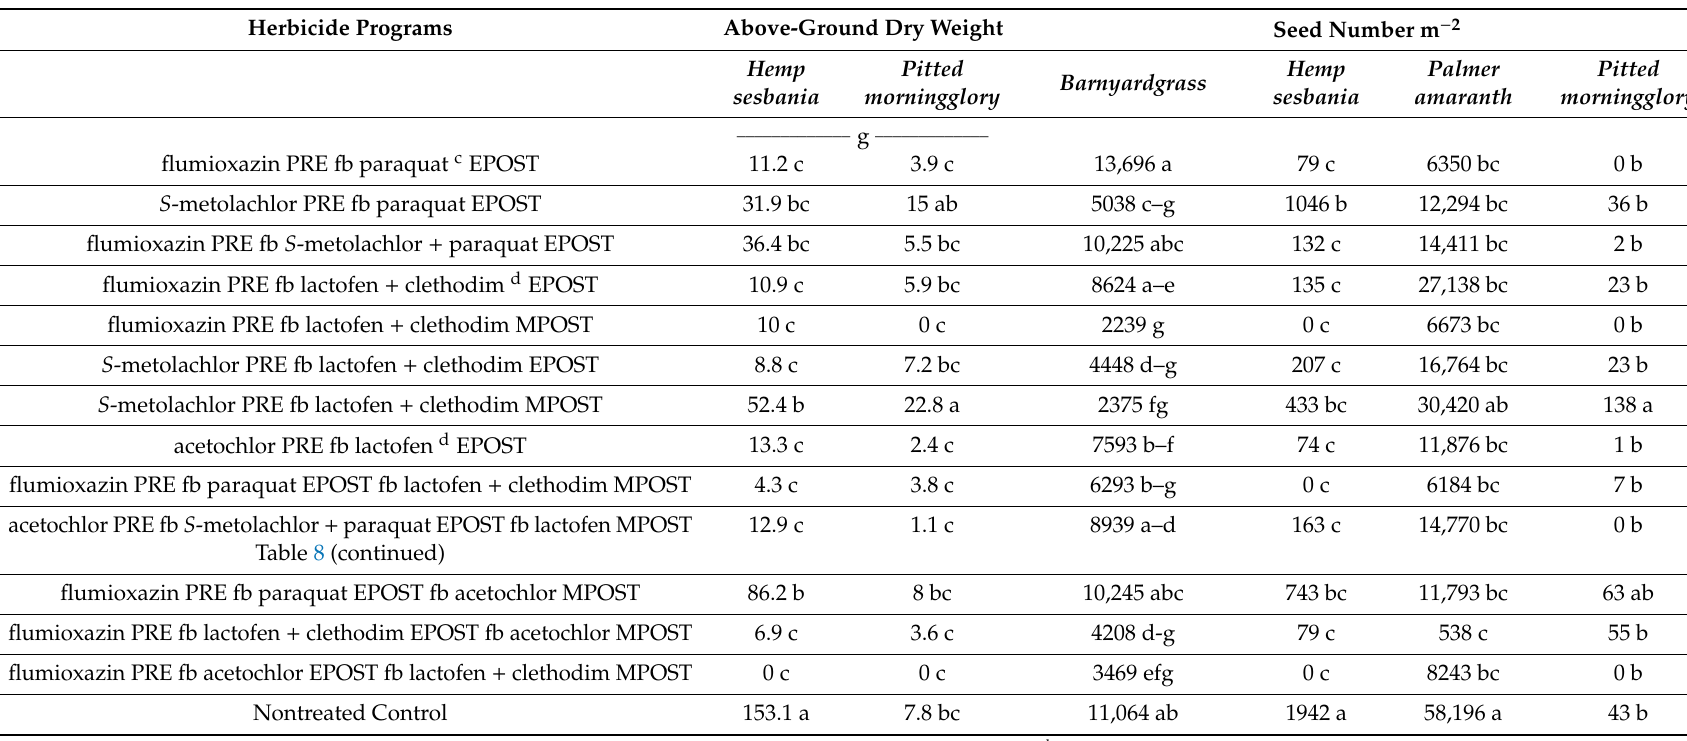
Table 8. Above-ground dry weight of hemp sesbania and pitted morningglory m − 2 , as well as seed production for barnyardgrass, hemp sesbania, Palmer amaranth, and pitted morningglory m − 2 following PRE, EPOST b , and MPOST b herbicide programs prior to peanut harvest in Stoneville, MS, averaged over 2017 and 2018 a